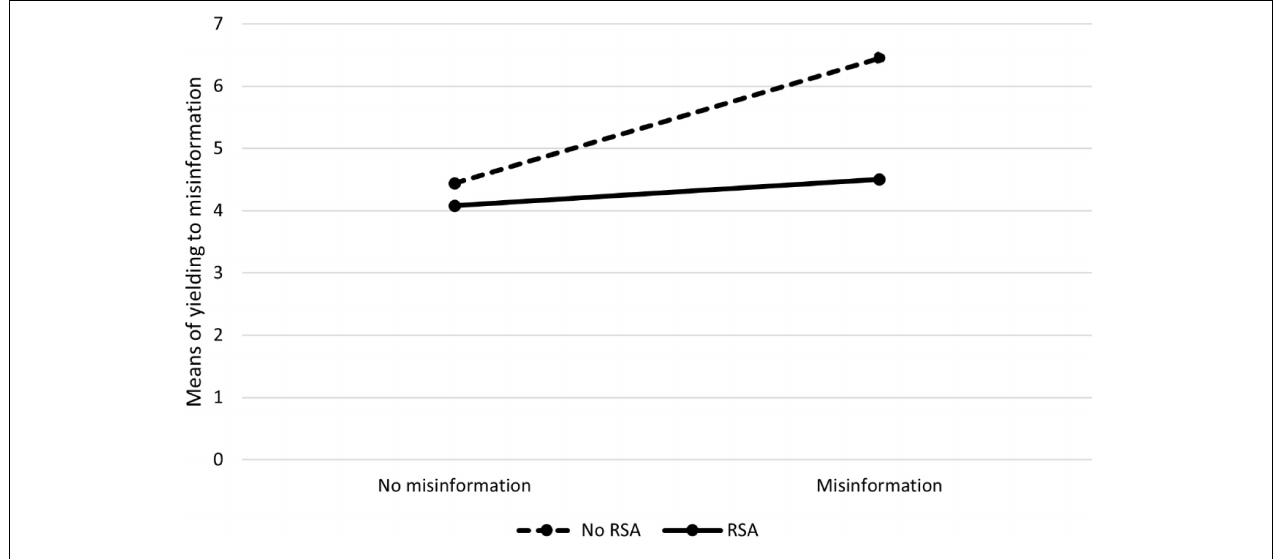
FIGURE 1 | Means of yielding to misinformation across experimental conditions in Experiment 1.